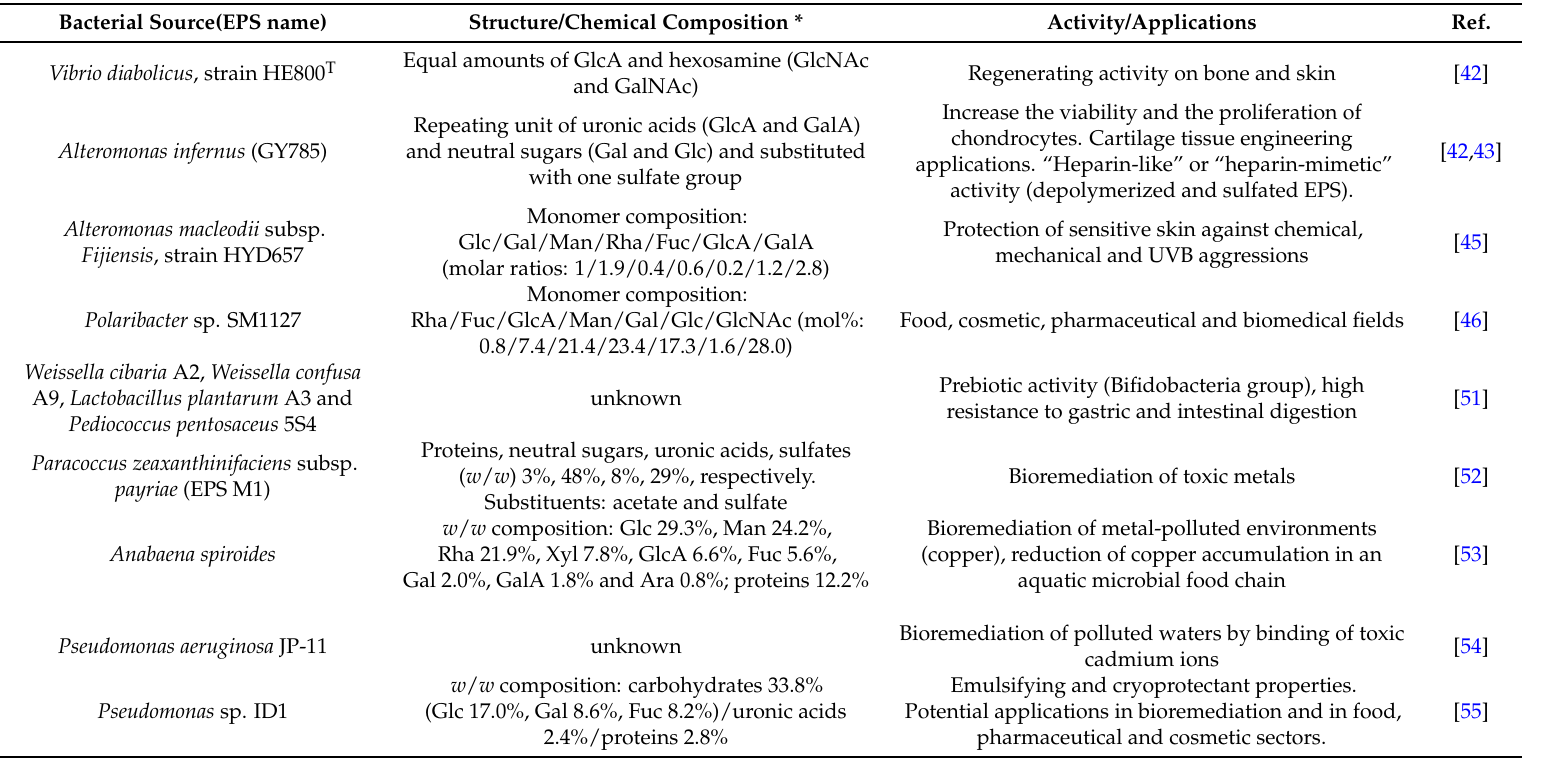
Table 1. Examples of biologically- and biotechnologically-useful marine